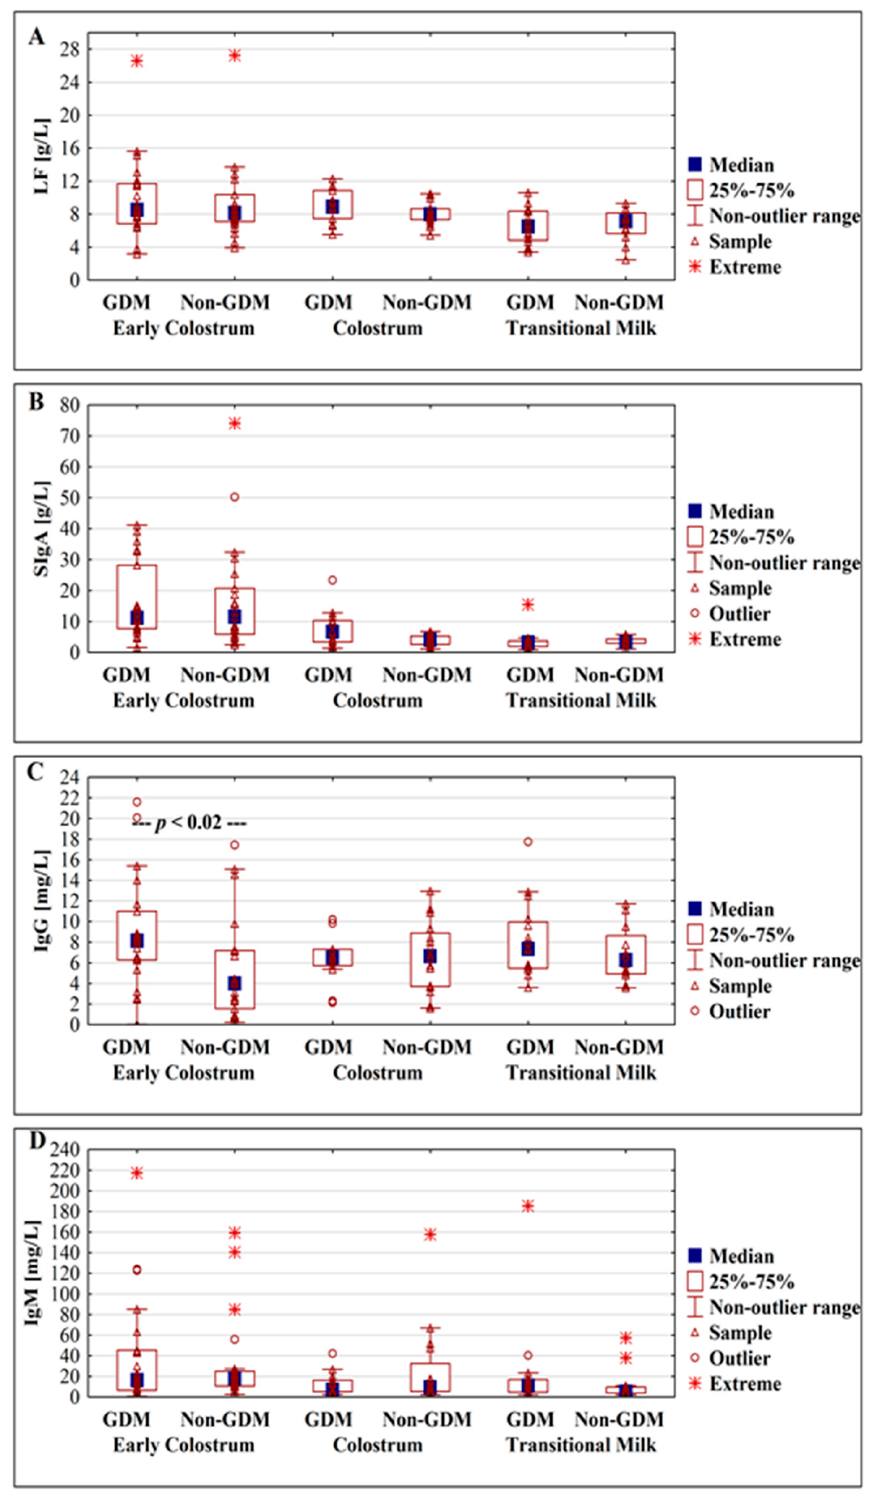
Figure 2. Box plot illustrating the change in concentrations of lactoferrin ( A ), SIgA ( B ), IgG ( C ), and IgM ( D ) in milk from gestational diabetic and normoglycemic (non-GDM) mothers during milk maturation from early colostrum to the transitional milk.